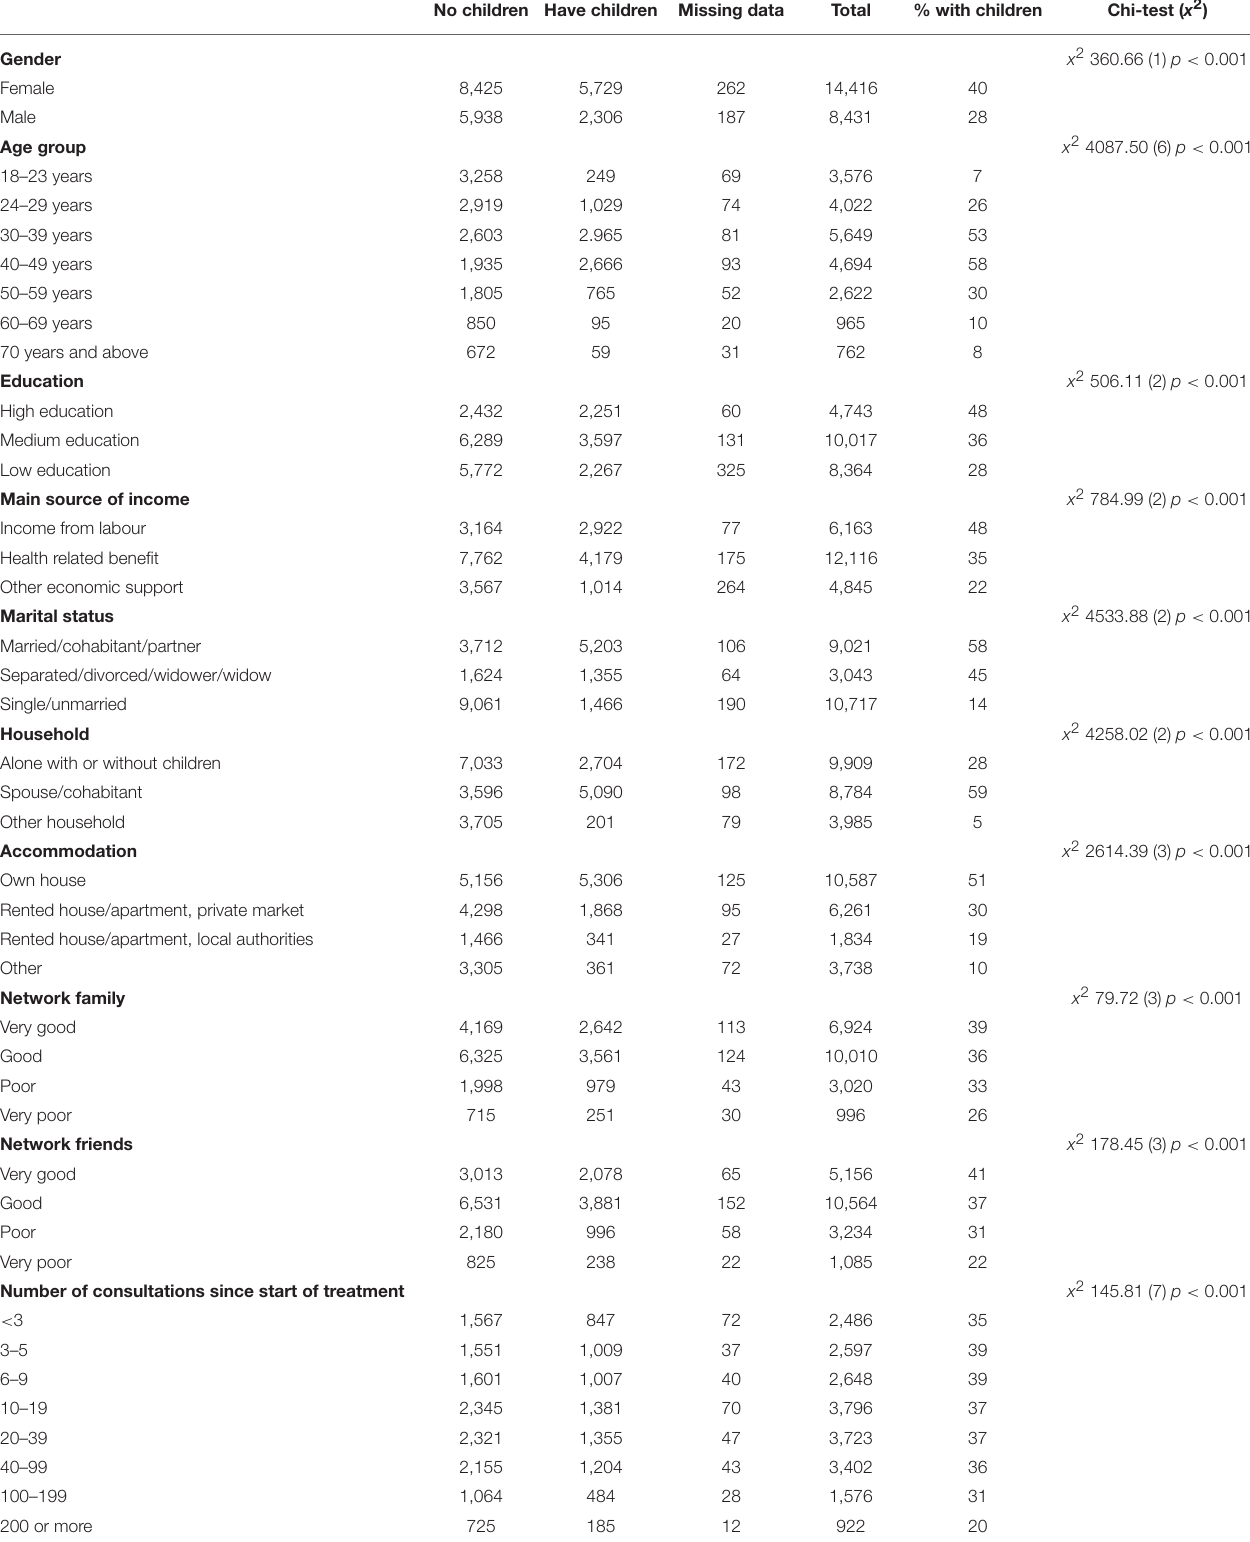
TABLE 1 | Bivariate analyses of the association between patient characteristics and outpatients ( N = 22,847) who care for children under 18. No children Have children Missing